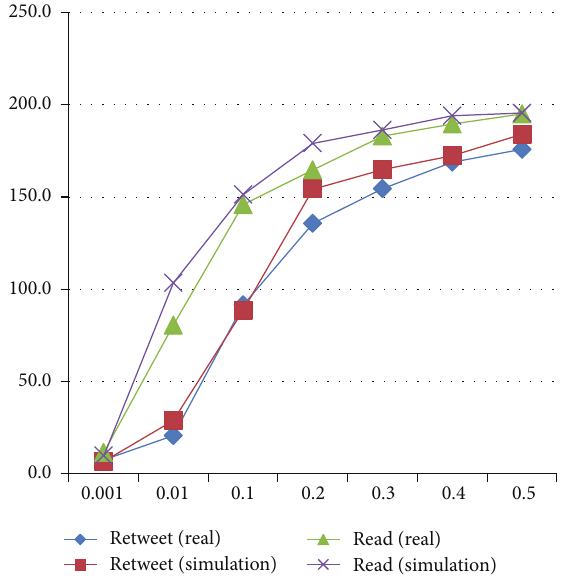
Figure 7: The relationship between the similarity of users’ interests with the propagators’ interests and knowledge